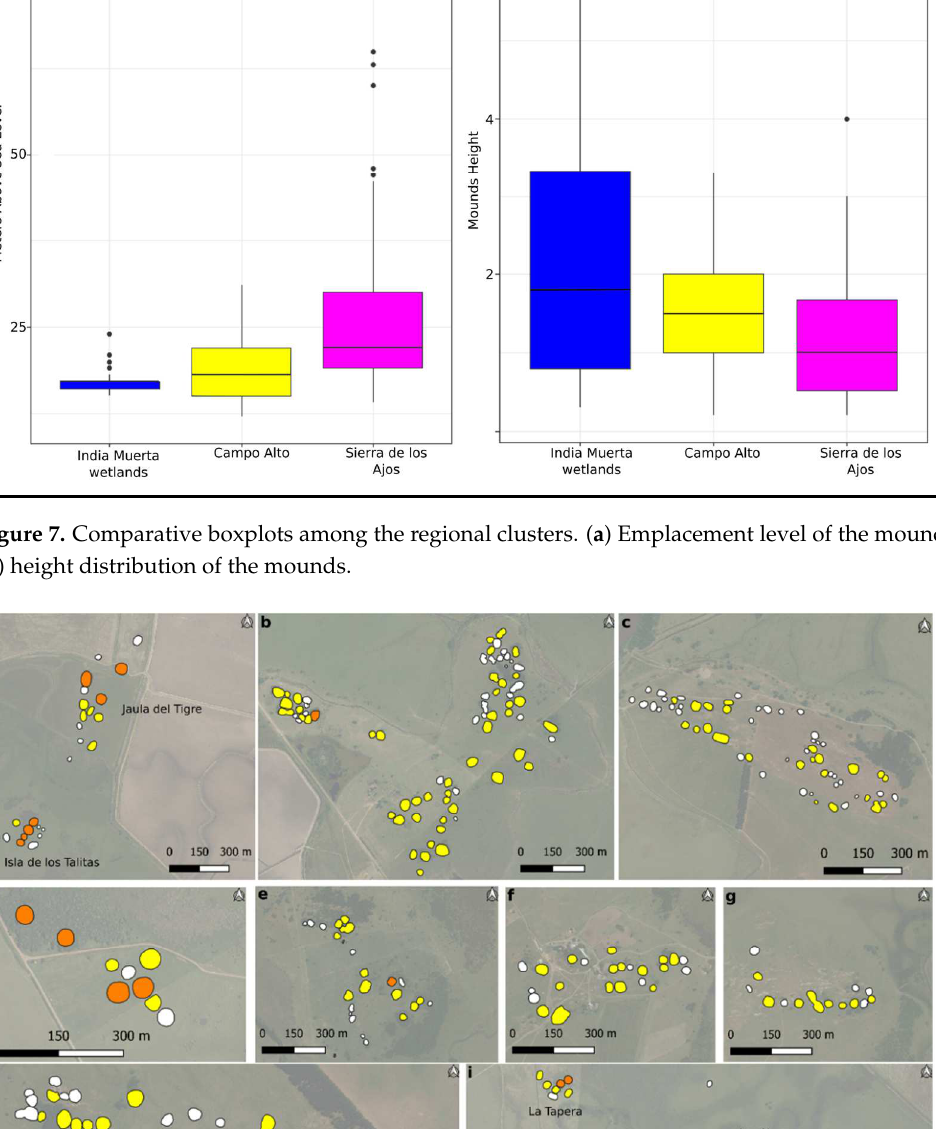
Figure 8. Maps with the spatial configuration discriminated by mound heights in different sites of the study area. ( a ) Isla de los Talitas and Jaula del Tigre (India Muerta wetlands cluster), ( b ) Mal Abrigo (Sierra de los Ajos cluster), ( c ) Colina Damonte (Sierra de los Ajos cluster), ( d ) Garc í a Ricci (India Muerta wetlands cluster), ( e ) Cabrera B (Campo Alto cluster), ( f ) Cerro Alto C (Campo Alto cluster), ( g ) El Solitario (Campo Alto cluster), ( h ) Los Ajos (Sierra de Los Ajos cluster), ( i ) La Tapera, Los Huesos and La Viuda (India Muerta wetlands